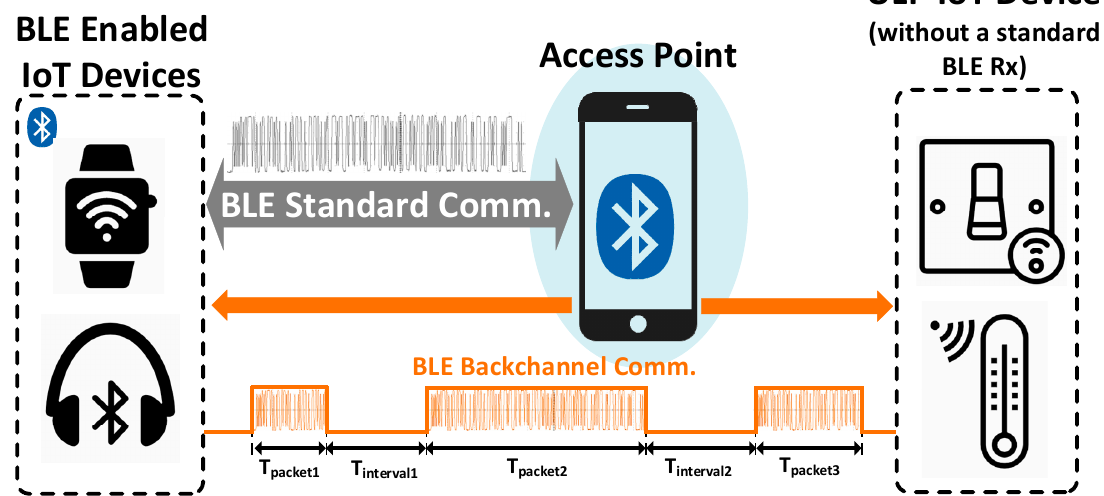
Figure 4. Concept of BLE (Bluetooth Low-Energy)-based back-channel communication.